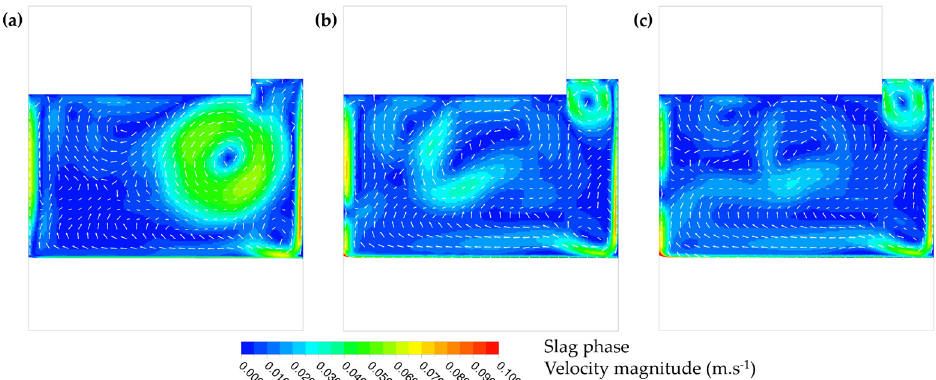
Figure 11. Slag phase velocity magnitude and normalized slag velocity vectors (time-averaged) considering the fall of 1 mm ( a ), 5 mm ( b ) and 10 mm ( c ) drops.